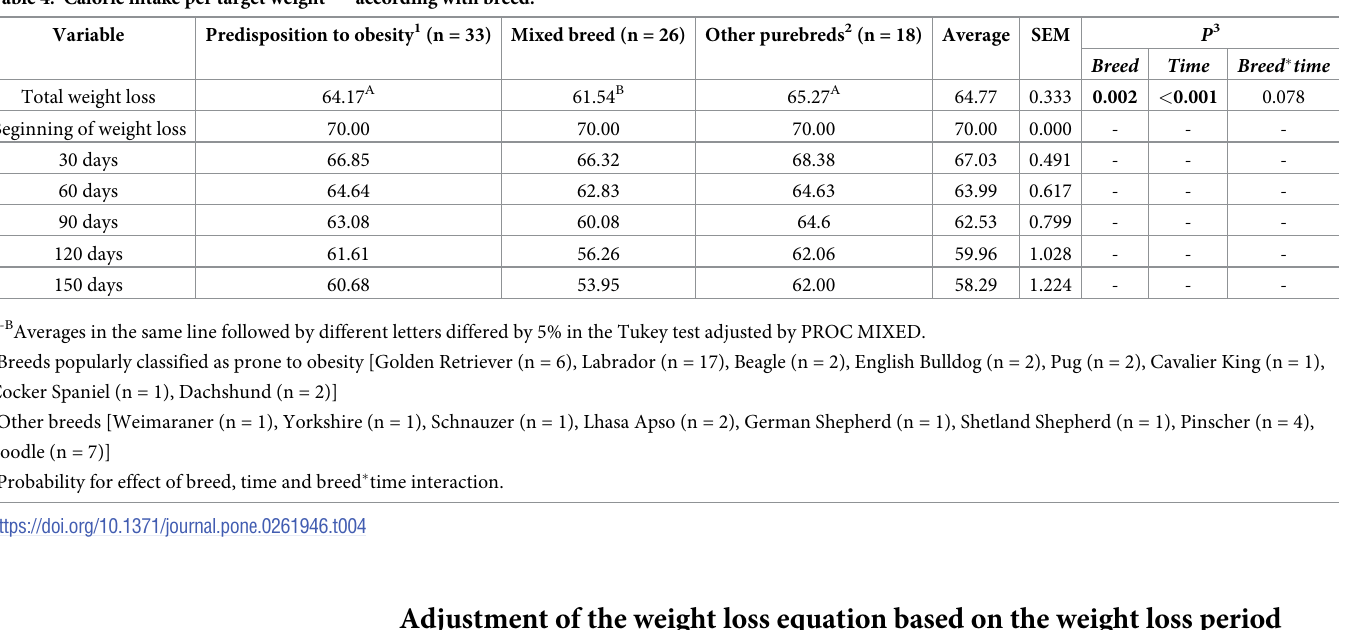
Table 4. Calorie intake per target weight 0.75 according with breed. Variable